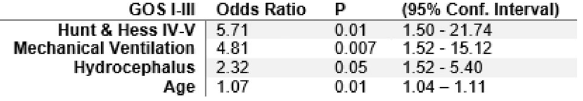
Table 2 (abstract 001371). See text for description